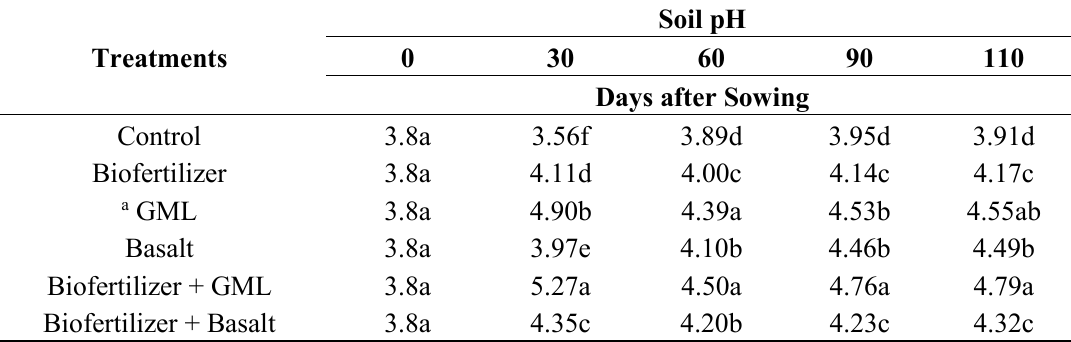
Table 3. Effects of biofertilizer, ground magnesium limestone GML and basalt application on soil pH.